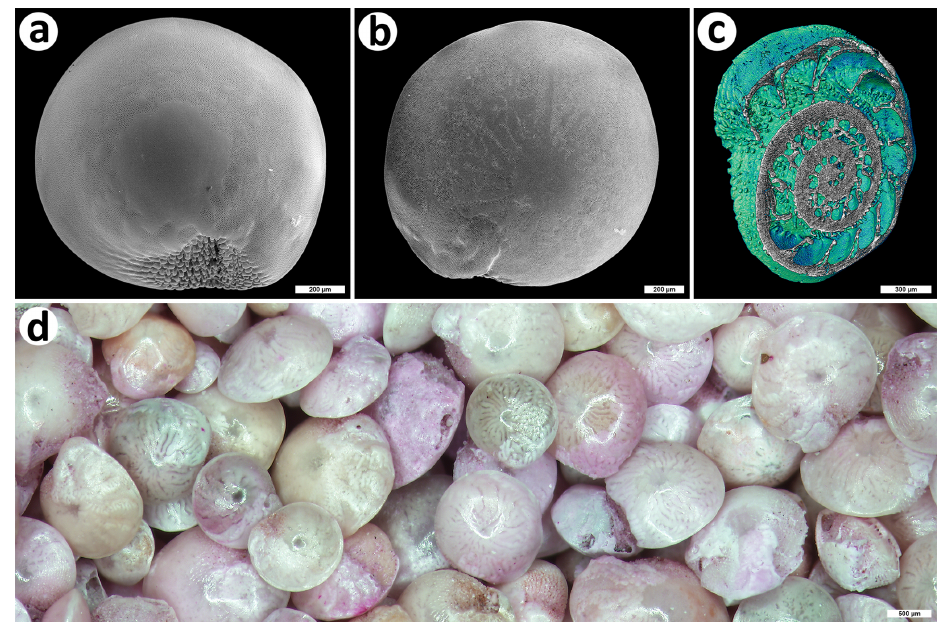
Figure 1. The invasive foraminiferan Amphistegina lobifera from Balluta Bay, St. Julian’s, Malta. (a) Ventral view, SEM; bar is 200µm; (b) dorsal view, SEM; bar is 200µm; (c) micro-CT 3D reconstruction (colored to contrast inner structure); bar is 300µm; (d) magnified view of an A. lobifera assemblage (some specimens stained with rose bengal); bar is 500µm. The shells were collected by Martin Vohník; photos were taken by Jiˇrí Machaˇc, Institute of Botany, Czech Academy of Sciences, Pr˚uhonice, under Martin Vohník’s supervision (a, b) and Zuzana Heˇrmanová, National Museum, Prague, (c) and Martin Vohník (d)